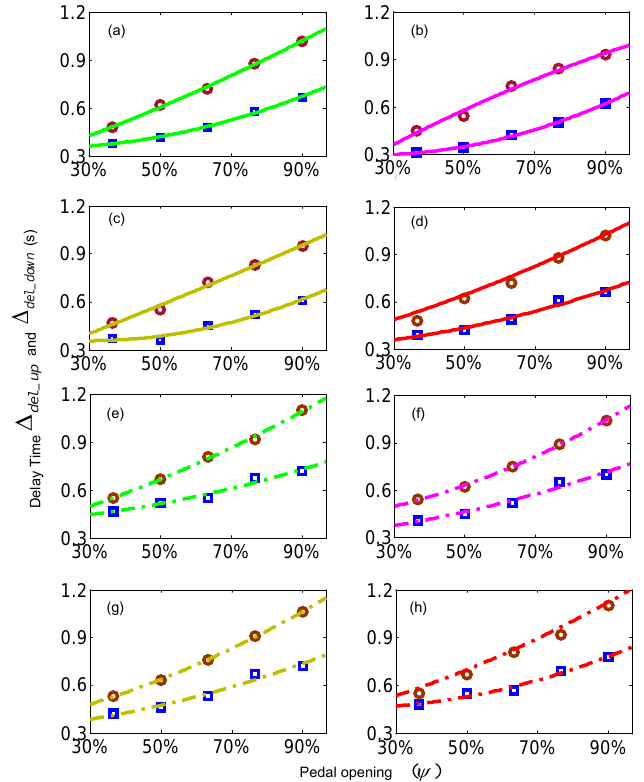
Figure 10. Relationships between pedal opening and delay time of eight loops. ( a )–( h ) refer to, respectively, loop A, B, C, …, H. The curve with marker “o” is ∆ del _ up , and with marker “ (cid:3) ” is ∆ del _ down .